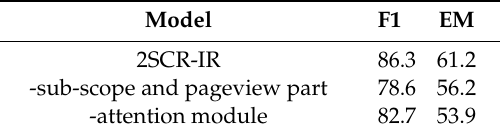
Table 4. Ablation results on dev